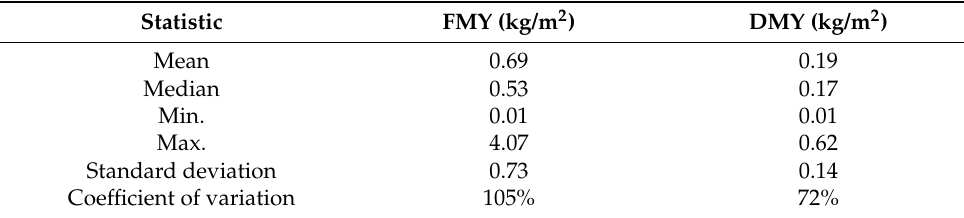
Table 2. Overview of aggregated FMY and DMY biomass (kg/m 2 ) data ( n =